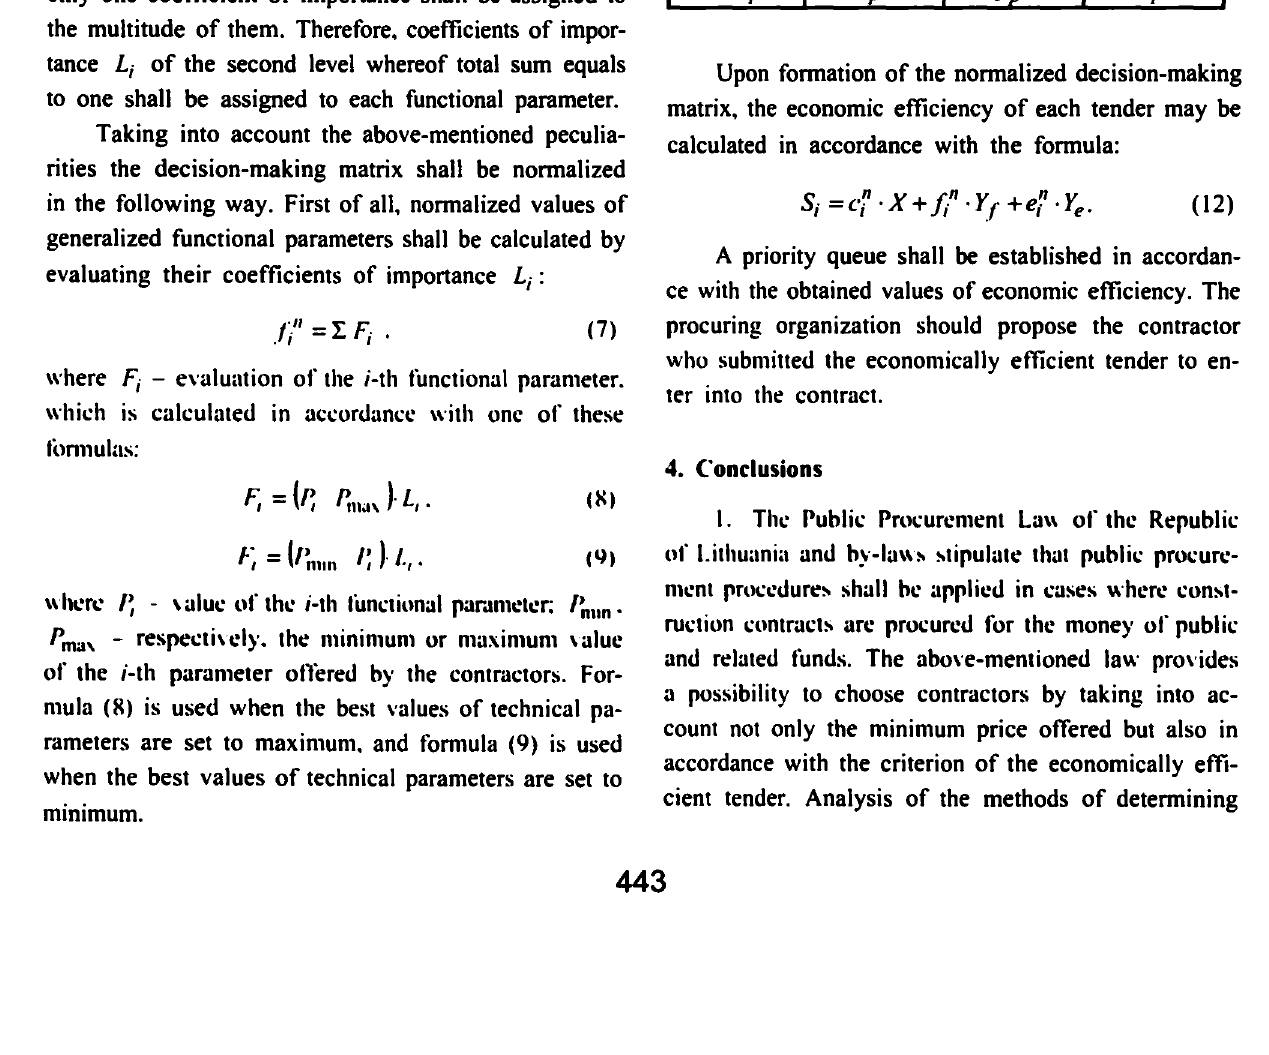
Table S. Nonnalized decision-making matrix